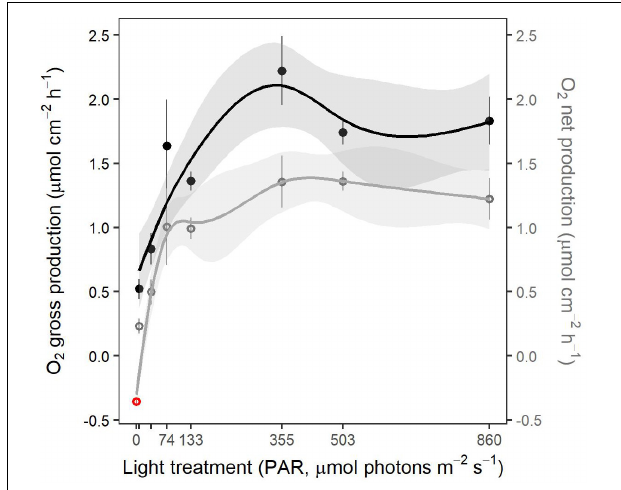
FIGURE 5 | Net primary production (NPP) and gross primary production (GPP) standardized by photosynthetic leaf surface ( µ mol O 2 h − 1 cm − 2 ) of whole eelgrass shoots from each light treatment at the end of the experiment. Dotted values are mean ± SE ( n = 5–6 shoots). NPP at 0 µ mol photons m − 2 s − 1 (red circle) is the mean respiration rate measured throughout the range of light treatments ( n = 41). Lines represent the fitted values from HGAM models with a 95% CI.